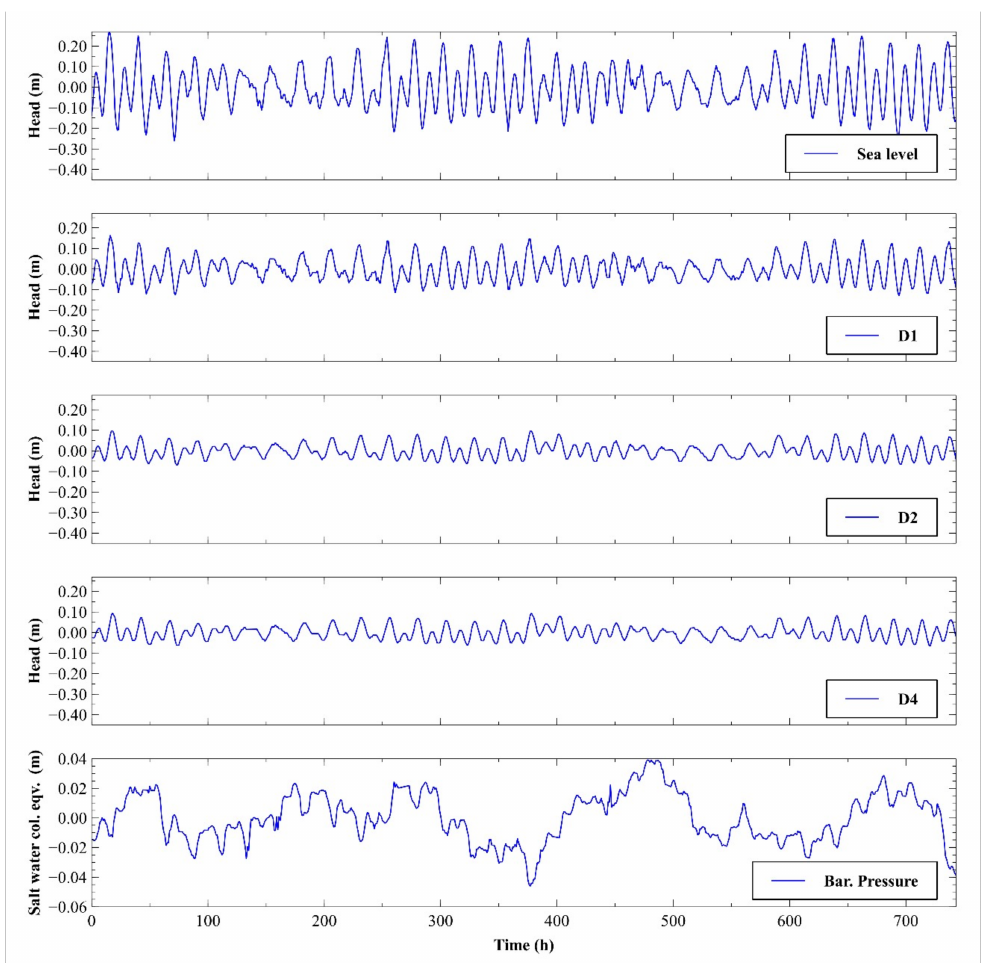
Figure 4. Sea level; D1, D2, and D4 piezometric head detrended and scaled signals h OBSERVED (cid:48) ; and detrended barometric pressure for the period of 1 August to 31 August